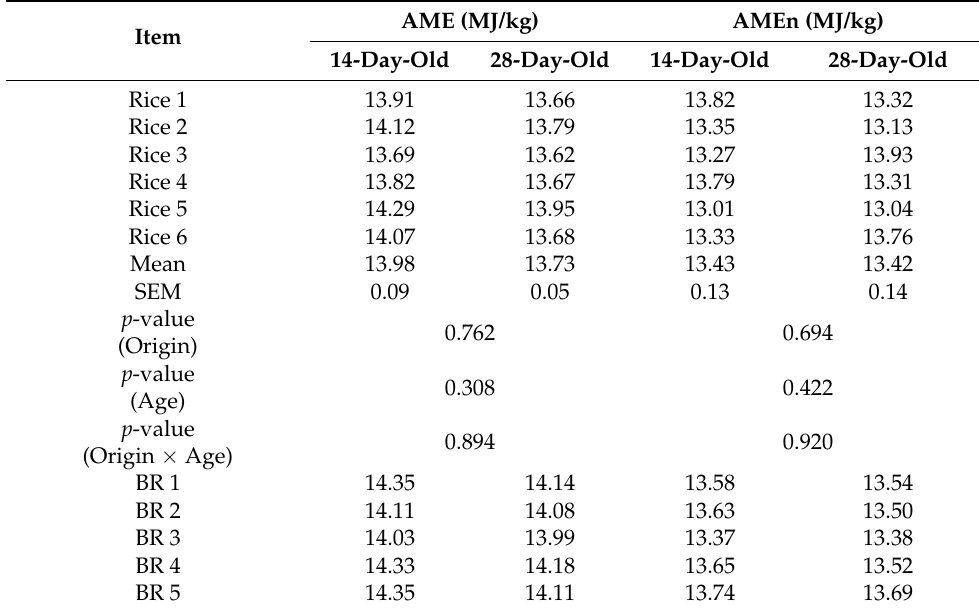
Table 6. Nitrogen-corrected apparent metabolized energy of different sources test ingredients in broilers